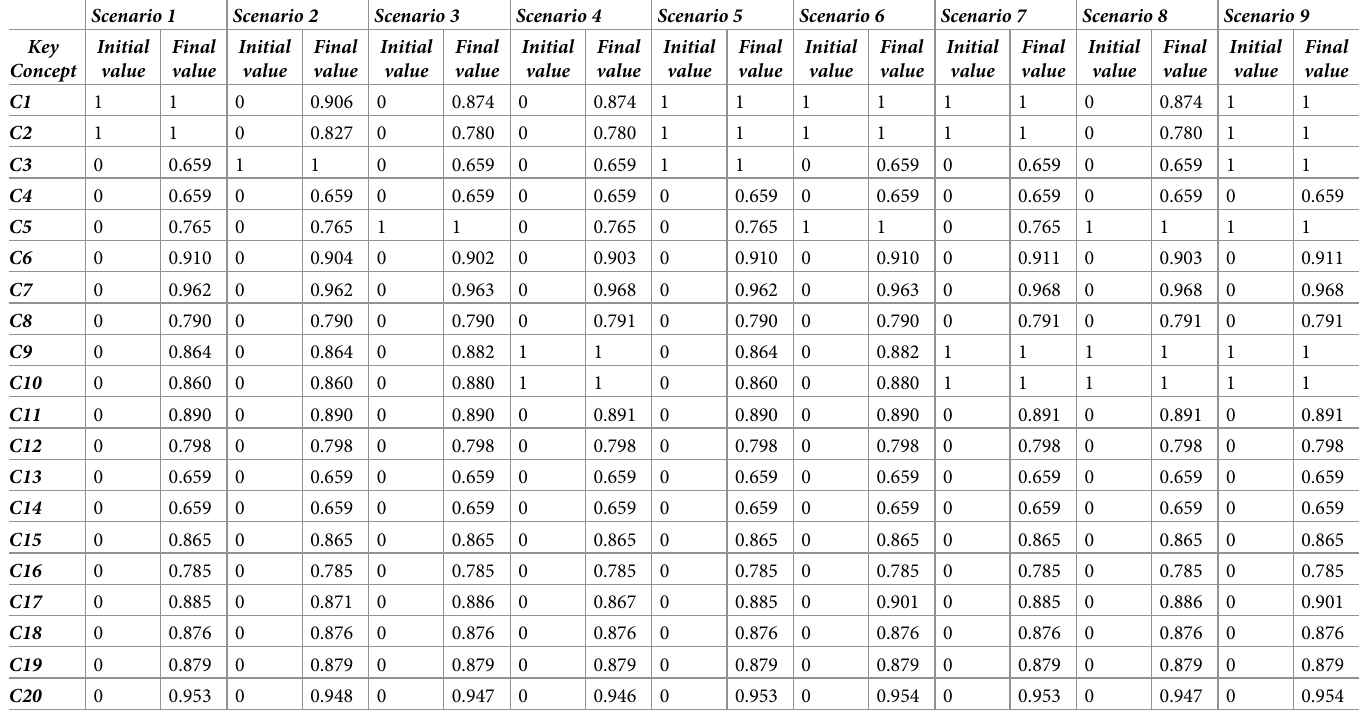
Table 3. Scenario results (initial and final value) for each concept, for the Expert-based